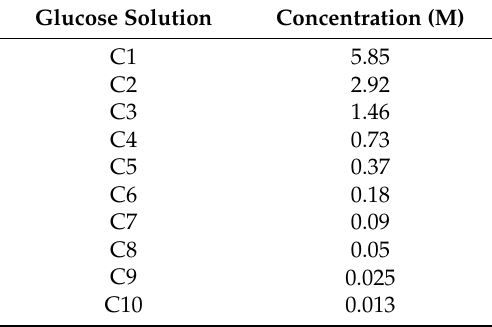
Table 2. Concentrations of the glucose